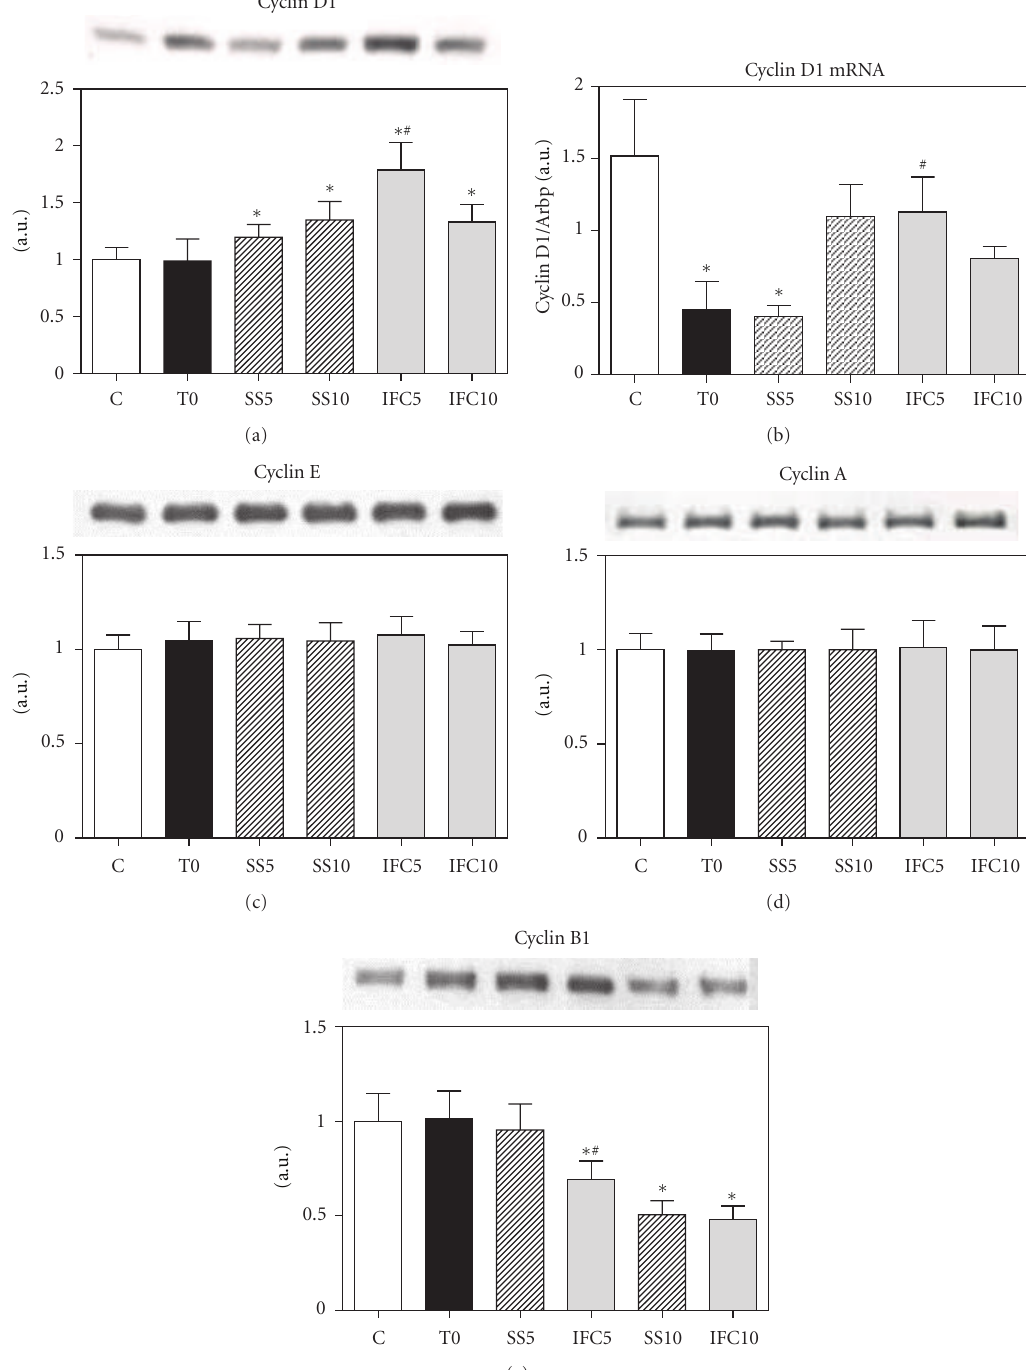
Figure 2: E ff ect of IFC305 treatment on cyclin D1, cyclin E, cyclin A, and cyclin B1 protein expression in CCl 4 -induced cirrhosis in rats. (a), (c), (d), and (e) Expression of the indicated proteins from liver nuclear extracts was determined by western blot analysis. A representative western blot image of each one is shown. The bar graph represents the densitometry analysis expressed as arbitrary units of the mean ± SEM from 3rats/group, values were normalized to β -actin immunodetection (image, Figure 1(a)). ∗ Statistical di ff erence ( P < 0 . 05) when compared to C group. # Statistical di ff erence ( P < 0 . 05) when compared to their respective experimental group SS5 or SS10. (b) E ff ect of IFC305 treatment on cyclin D1 mRNA expression in CCl 4 -induced cirrhosis in rats. RNA was isolated from liver and mRNA expression for cyclin D1 was analyzed by quantitative RT-PCR as described in Section 2. Arbitrary units were normalized with Arbp mRNA gene expression level. Data represent mean ± SEM from 3rats/group. ∗ Statistical di ff erence ( P < 0 . 05) compared to C group. # Statistical di ff erence ( P < 0 . 05) when compared to their respective experimental group SS5 or